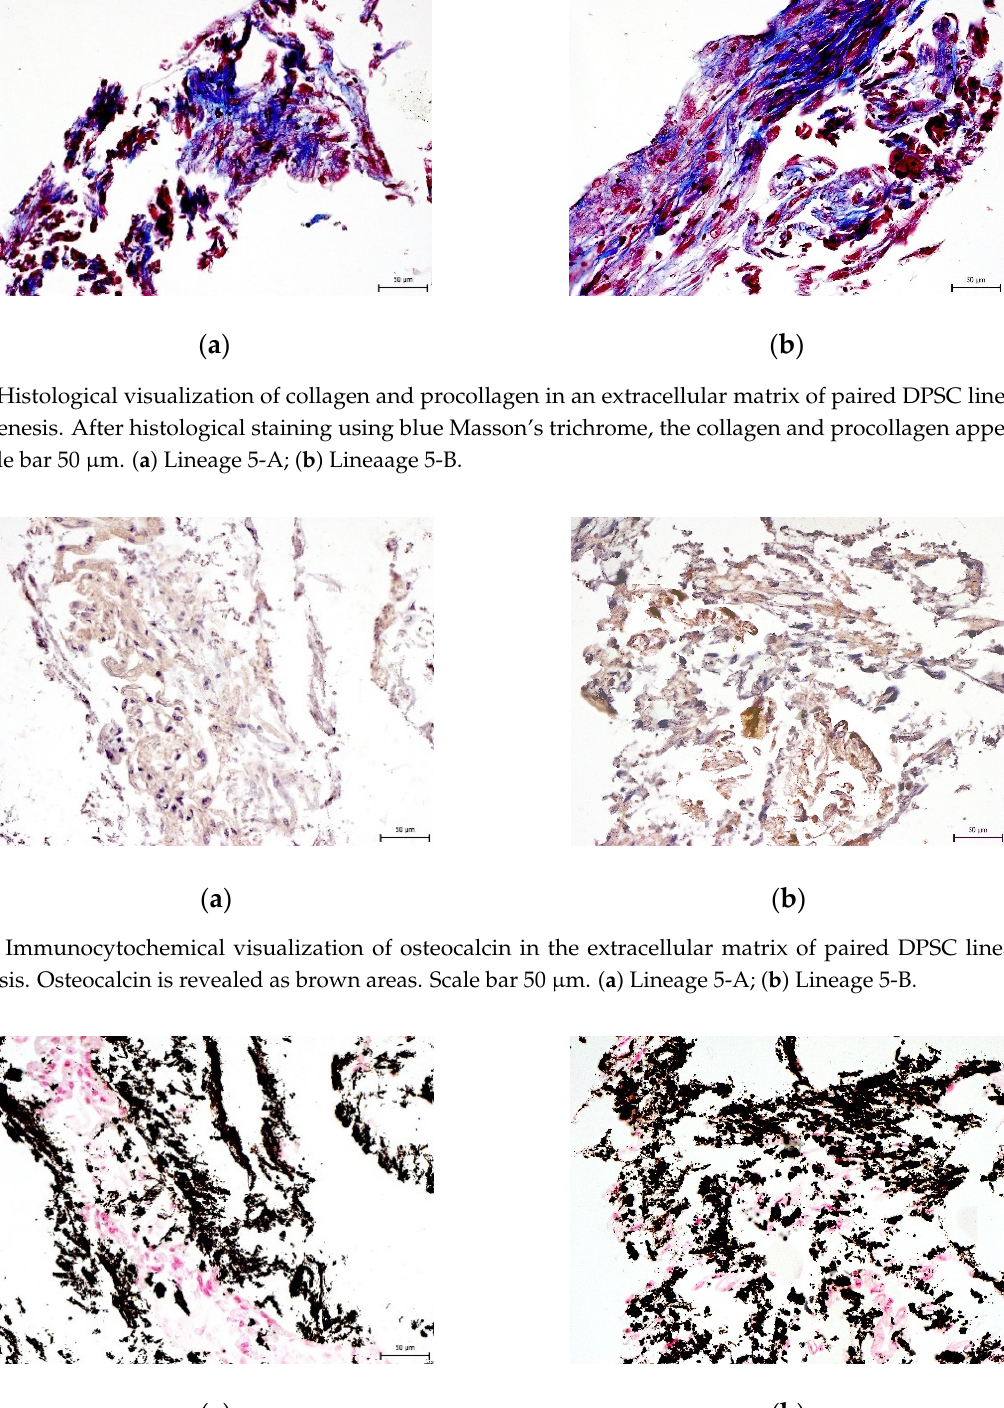
Figure 7. Immunocytochemical visualization of type II collagen in an extracellular matrix of paired DPSC lineages after chondrogenesis. Type II collagen shows up as fluorescent red, and stem cell nuclei fluorescent blue. Scale bar 50 μ m. ( a ) Lineage 5-A; ( b ) Lineage 5-B.